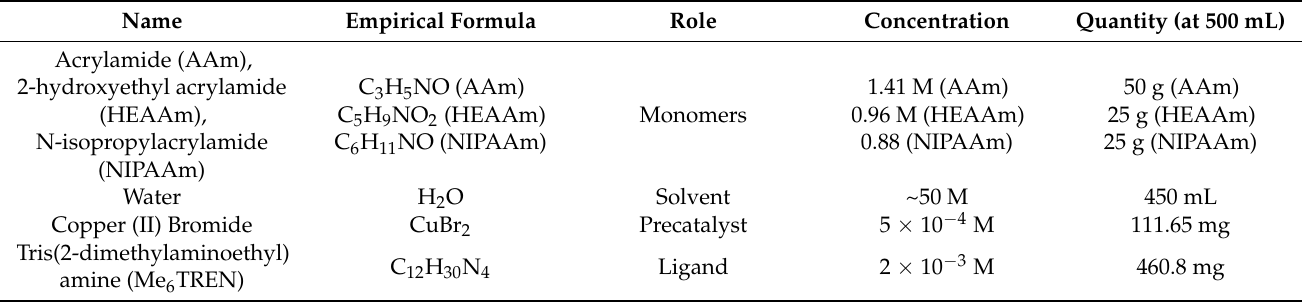
Table 2. Chemical composition mixture of the candidate polymerization up to scale-up factor